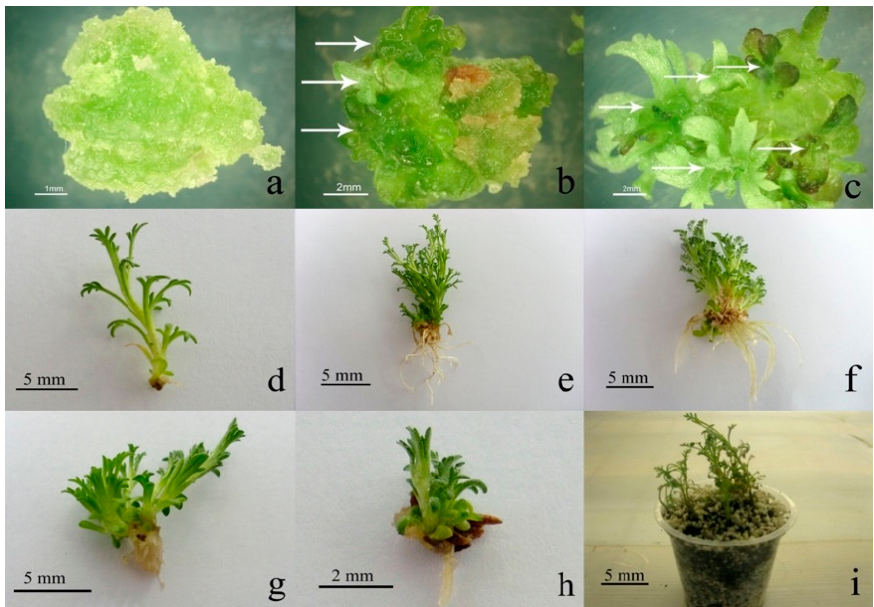
Figure 1. Different stages of callus formation and plantlet regeneration in Artemisia spicigera . Callus